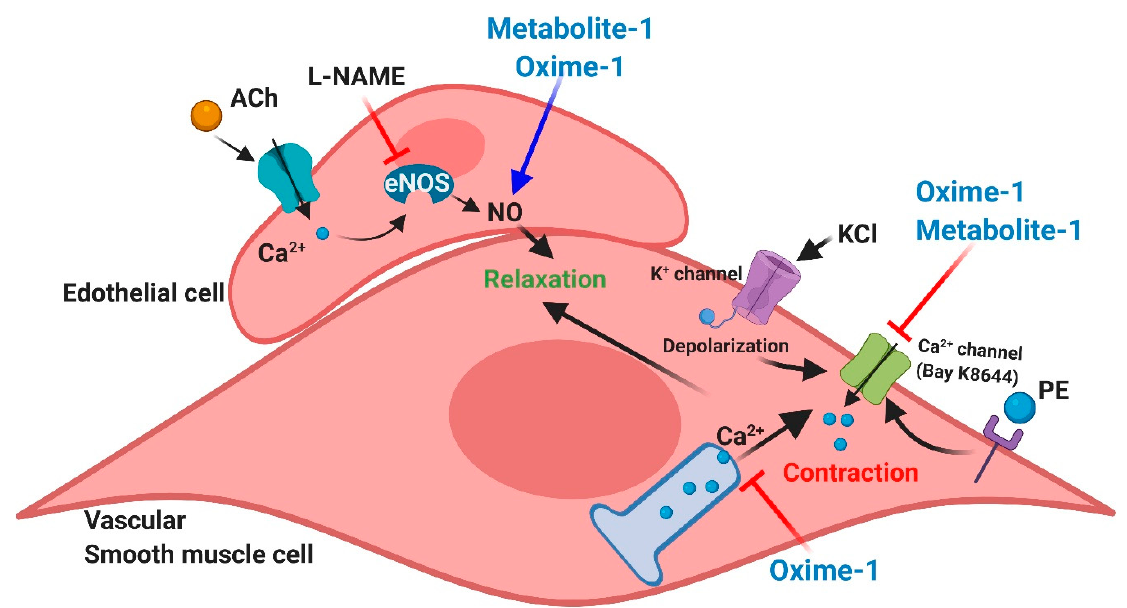
Figure 10. Putative model of vascular relaxation in rat blood vessel induced by oxime–1 and metabolite–1. Phenylephrine (PE) selectively stimulates the alpha-adrenergic receptor in vascular smooth cells, leading to vascular contraction by releasing Ca 2+ from intracellular stores and increased Ca 2+ influx from the extracellular space. KCl-induced contraction is due to the plasma membrane depolarization and Ca 2+ influx. Oxime–1 decreases the contractile response to PE by blunting the release of Ca 2+ from intracellular stores and blocking Ca 2+ influx by channels. Metabolite–1 reduces the contractile response to KCl, in part, because of the reduction of depolarization of plasma membrane and Ca 2+ influx from the extracellular space. Both bioactive molecules cause relaxation in rat aorta in an endothelium-dependent manner, through endothelial nitric oxide (NO).